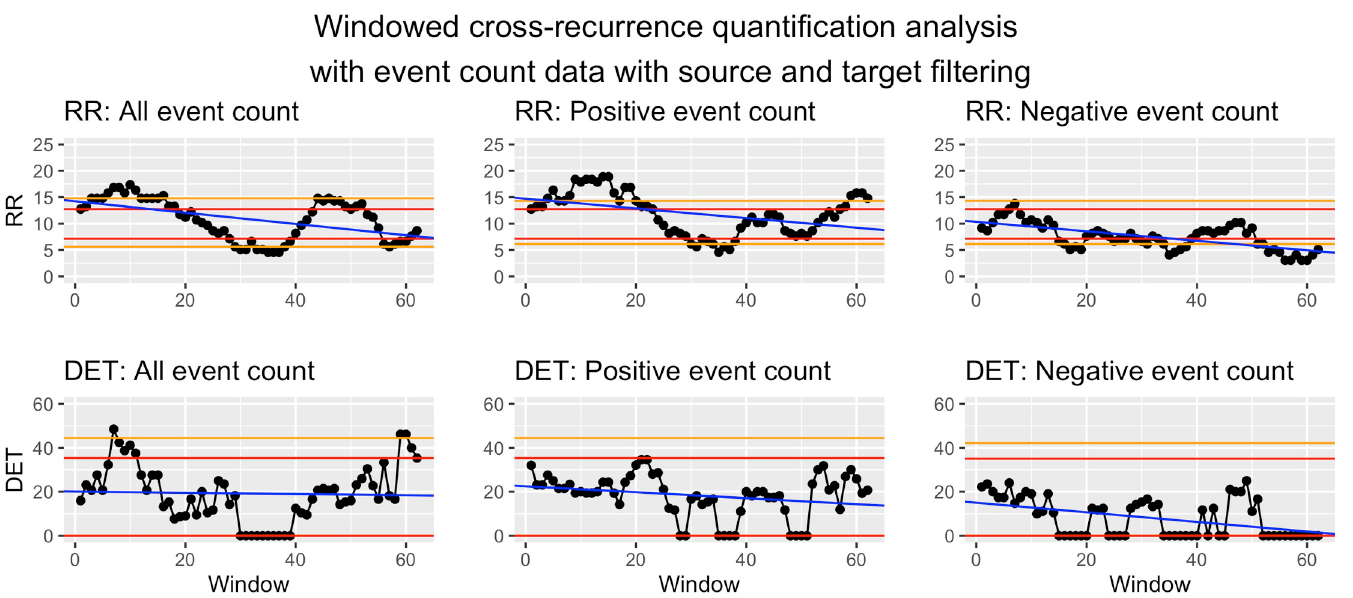
Fig 11. Windowed CRQA for social cohesion and event counts from source and target filtered